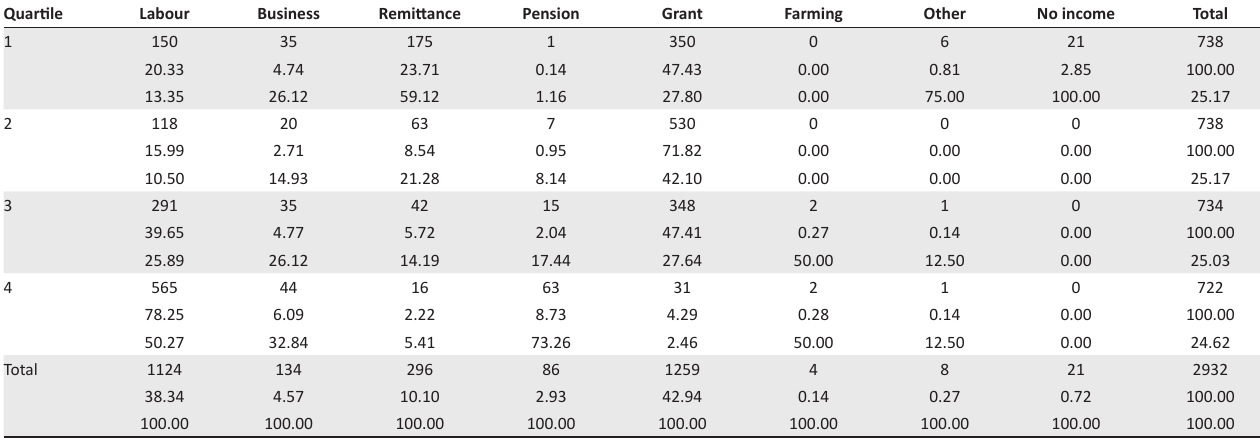
TABLE 6: Livelihood strategies as defined by income sources. Quartile